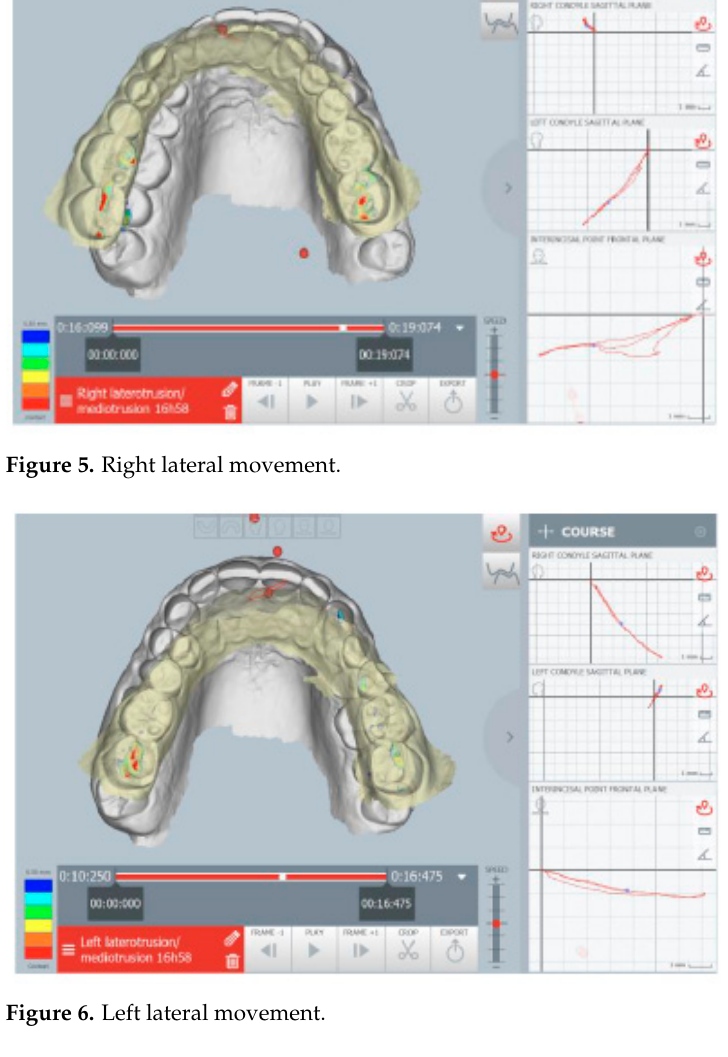
Figure 6. Left lateral movement.